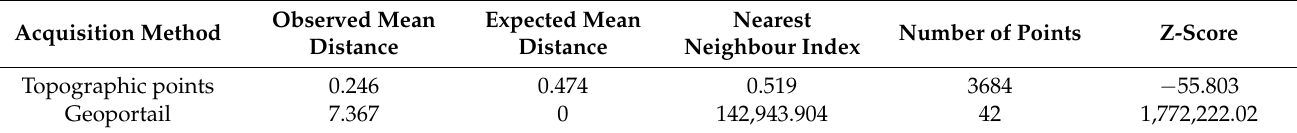
Table 1. Results of the nearest neighbor analysis algorithm obtained with QGIS